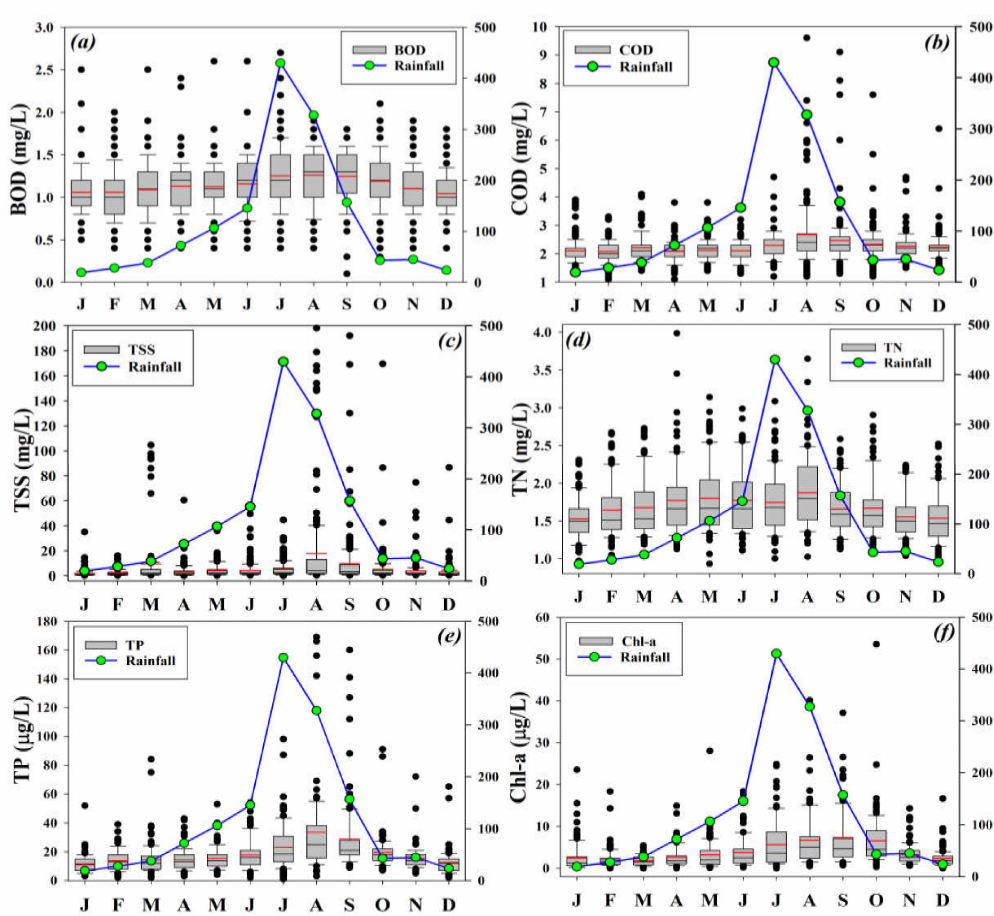
Figure 2. Monthly variabilities of the selected water chemistry parameters ( a ) BOD, ( b ) COD, ( c ) TSS, ( d ) TN, ( e ) TP, ( f ) Chl-a, in relation to seasonal rainfall (mm) intensity during 1992–2013. The right-hand y-axis indicates rainfall